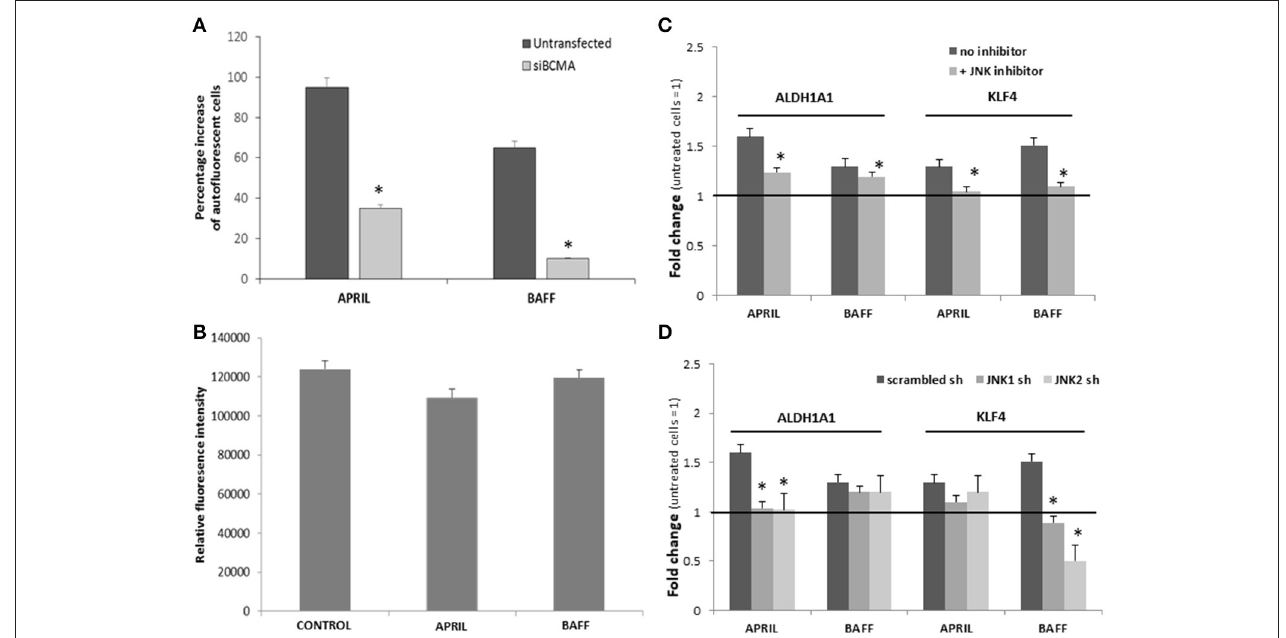
FIGURE 5 | (A) Effect of APRIL and BAFF on breast cancer stem cells in the presence of siBCMA . Percentage increase in the number of breast cancer stem cells transfected or untransfected with siBCMA and treated with BAFF or APRIL (100ng/ml) for 4 days. (Breast cancer stem cell number was estimated by counting the cells with high green autofluoresence in a BL2-A/BL1-A dot plot). (B) NFk-B activity of untreated (control) and treated with APRIL or BAFF (100ng/ml, for 24h) T47D cells. Experiments were performed in triplicate. (C,D) Effect of APRIL and BAFF on ALDH1A1 and KLF4 expression in the presence of a JNK inhibitor or sh RNA for JNK1 or JNK2 . Expression levels of ALDH1A1 and KLF4 after treatment of T47D cells with APRIL or BAFF (100ng/ml) for 4 days in the presence of a JNK inhibitor SP600125 (10 µ M) (C) or sh RNA for JNK1 or JNK2 (D) . Data are presented as a mean ± SE of three independent experiments (*denotes p < 0.05, at